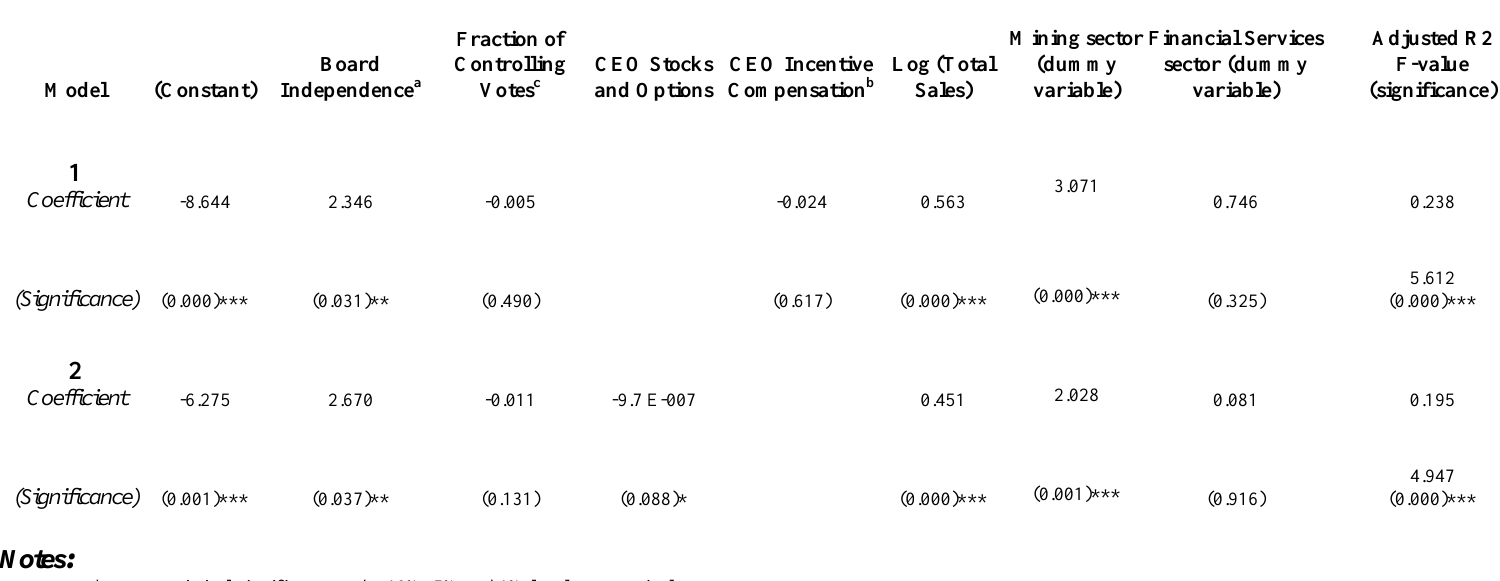
Table 5: Multiple Regression Results: Risk disclosure and